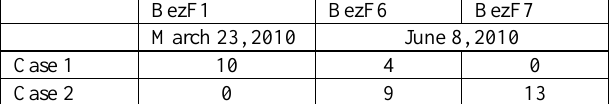
Table 5: Overview on problem cases. Case 1: Missing orientation parameters but existing image file. Case 2: Missing orientation parameters AND missing image